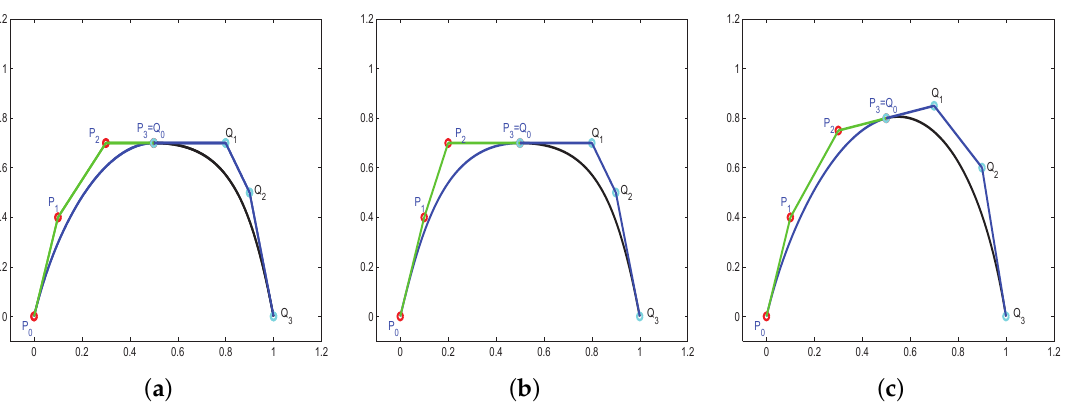
Figure 3. Parametric continuity. ( a ) C 0 continuity T 2 ( 1 ) = T 1 ( 0 ) ; ( b ) C 1 continuity T i